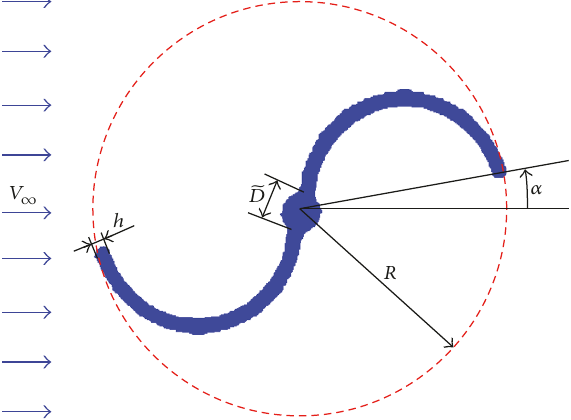
Figure 5: Schematic of the two-bucket Savonius rotor.